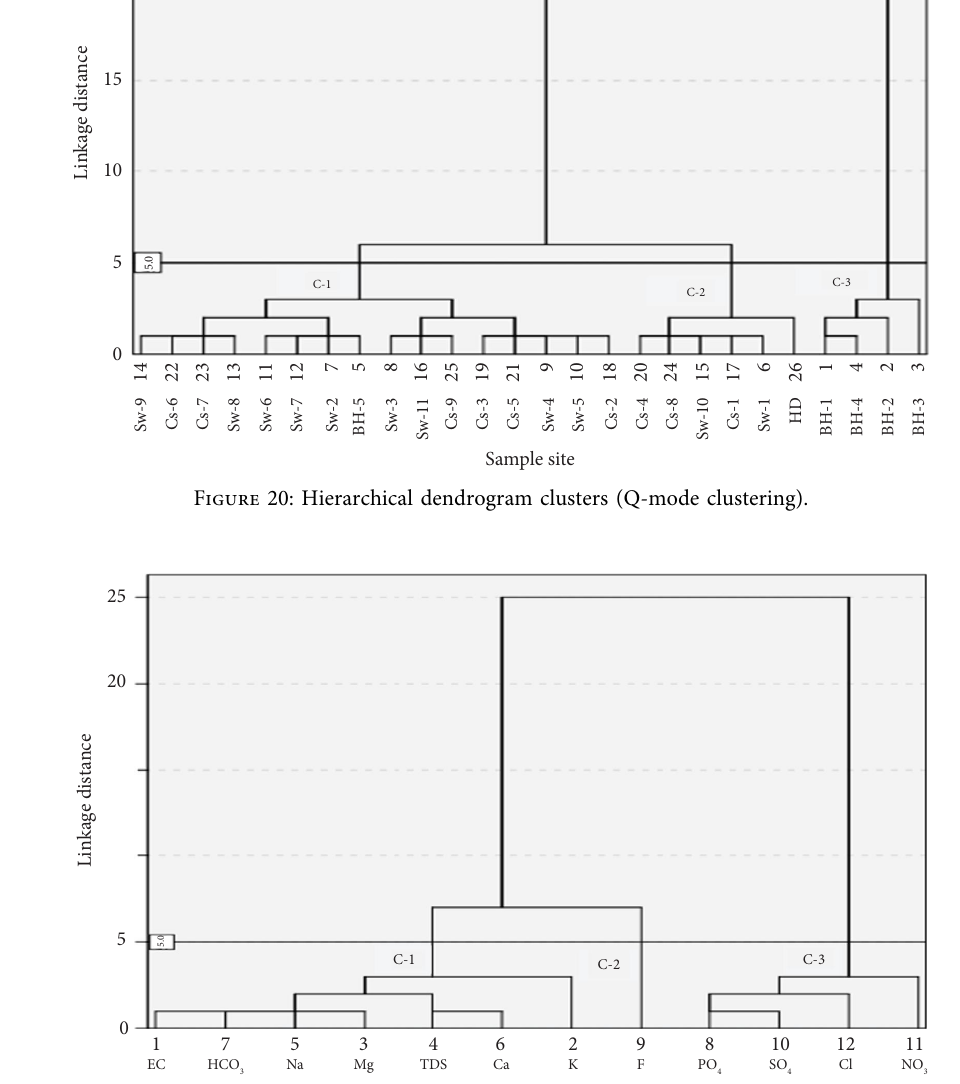
Figure 21: Hierarchical dendrogram cluster (R-mode